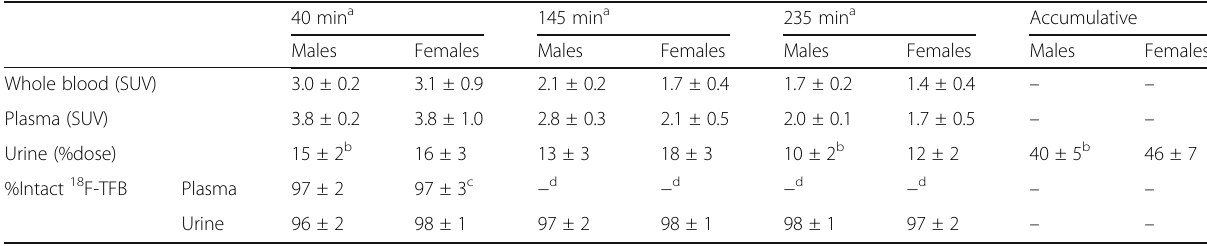
Table 2 Metabolite analysis of 18 F-TFB in plasma and urine of healthy